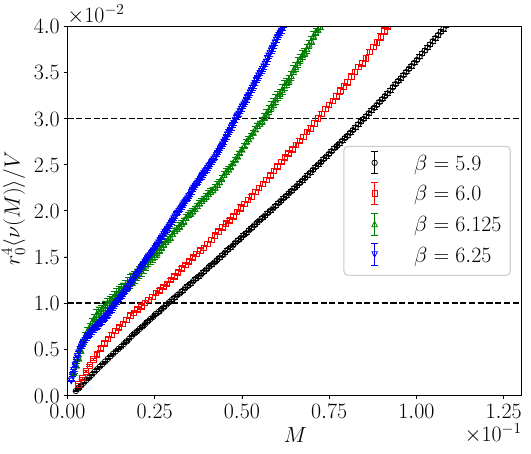
while M is reported in lattice units. 0